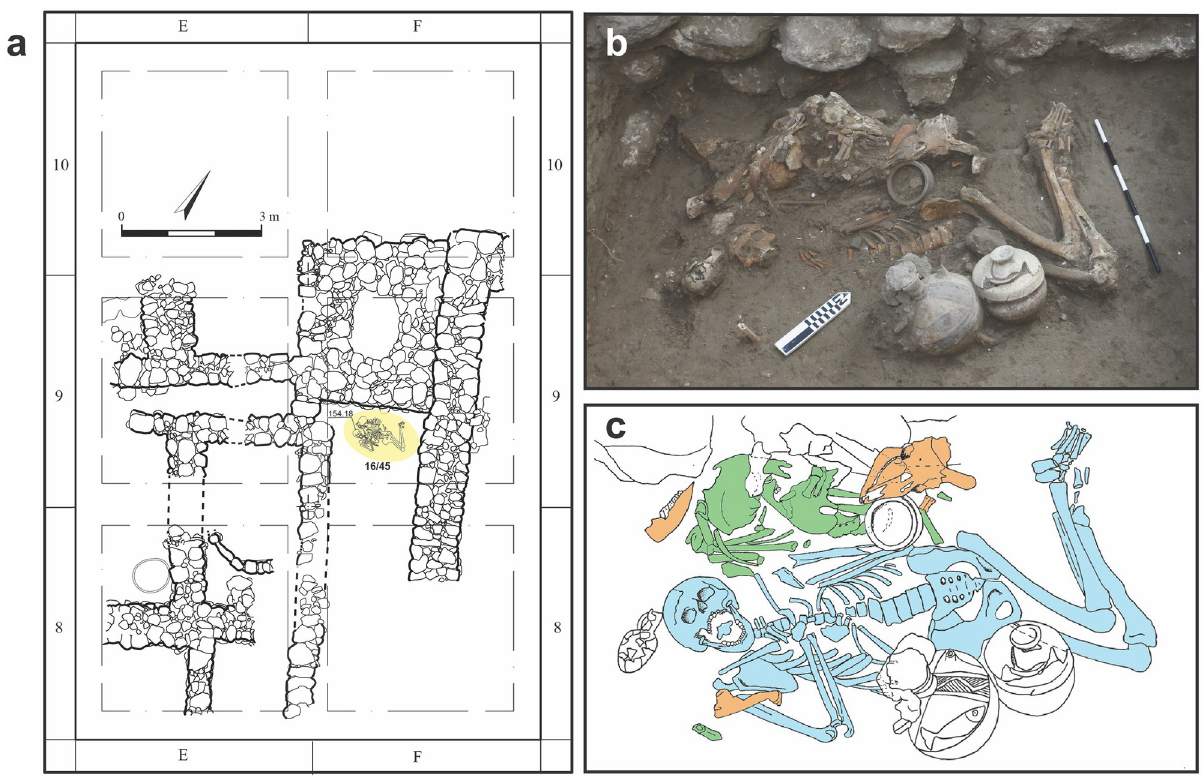
Fig 2. Bioarchaeological context of this study. a: The Area H (H-15) domestic structure, with Tomb 45 highlighted in yellow. (Adapted from [7] under a CC BY license, with permission from the Megiddo Expedition, original copyright 2022). b: In-situ photograph of early exposure of burial context. c: Composite drawing featuring all layers. Individual 1 is blue, Individual 2 is green, faunal remains are orange. Note the fragment of Individual 2 to the right of Individual 1’s right humerus.